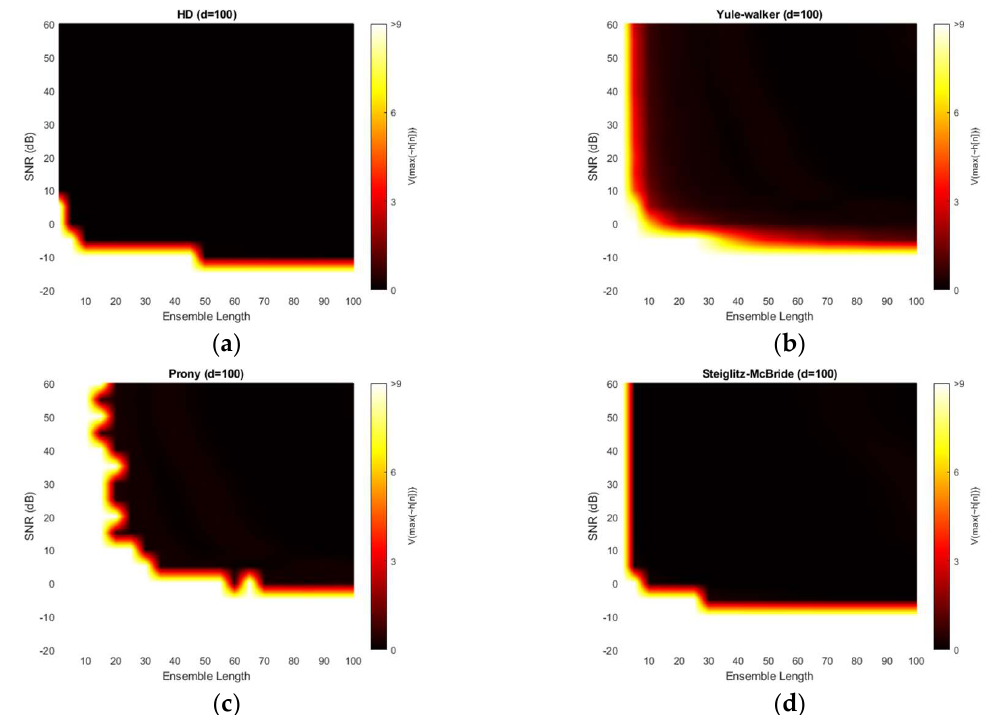
Figure 14. Variance of estimation with given ensemble average length & SNR for 100-sample delay: ( a ) non-parametric HD; ( b ) Yule-walker HD; ( c ) Prony HD; ( d ) Steiglitz-McBride HD.